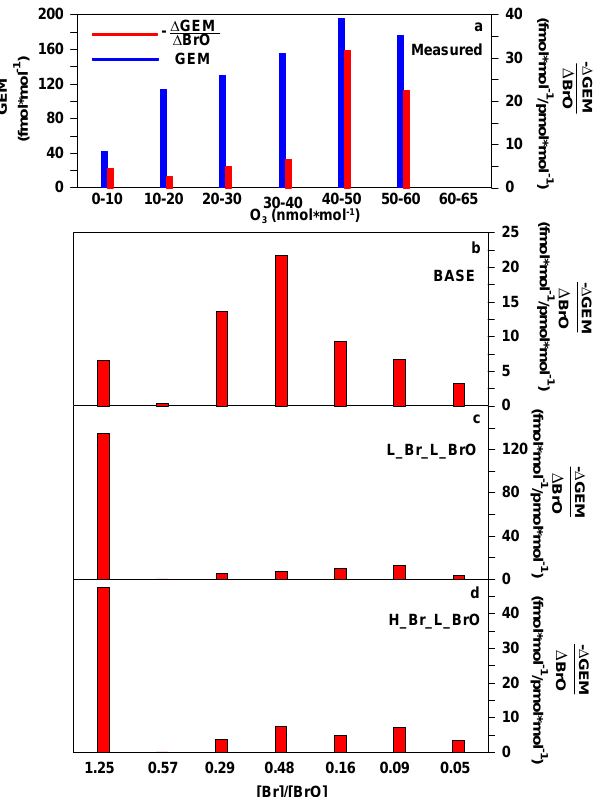
Fig. 5. Relative importance of Br and BrO to GEM-oxidation based on underlying LP-DOAS O 3 mixing ratios. (a) Measured GEM de- pletion per unit BrO (i.e., 1 GEM/ 1 BrO) is presented as a function of O 3 . 1 GEM/ 1 BrO was calculated for all campaign days and av- eraged for respective O 3 values. (b–d) Simulated 1 GEM/ 1 BrO as a function of [Br]/[BrO] for simulations L Br H BrO (i.e., “BASE”; b ), L Br L BrO (c) , and H Br L BrO (d) . Measured O 3 are expected to correspond to [Br]/[BrO] ratios in simulations due to known correlations between the two. Simulated 1 GEM/ 1 BrO values were calculated only for periods of 1 BrO > 0 based on Ju- lian days 188, 197, and